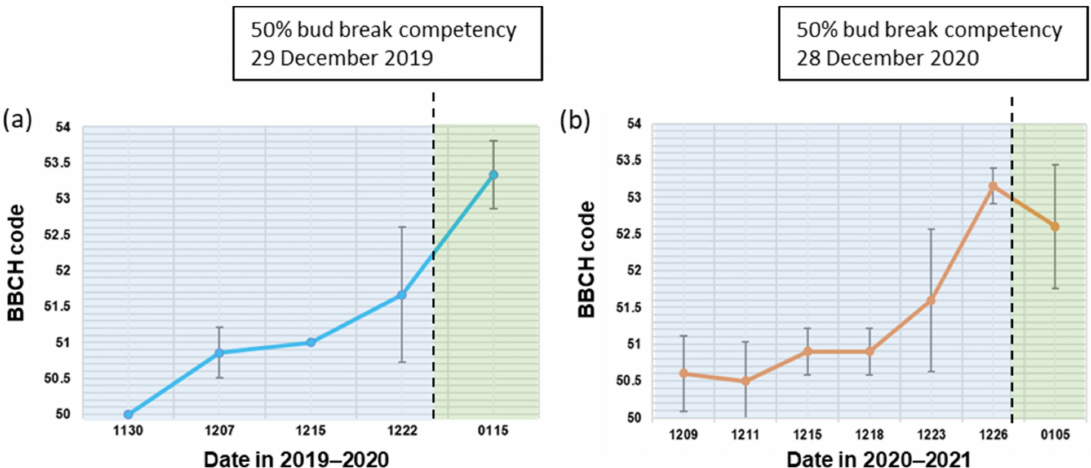
Figure 7. BBCH scale evaluation of ‘Nanko’ floral buds during December in 2019–2020 and 2020–2021 seasons: ( a ) 2019–2020, ( b ) 2020–2021. Ten flower buds from each stage were analyzed in 2019/2020 and 20 flower buds were examined from each stage. The error bars represent the SE. Dash line means the time point of 50% bud break